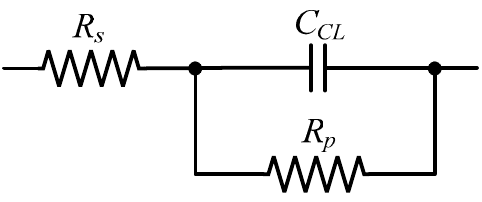
Figure 4. Electric equivalent circuit of NLC device.